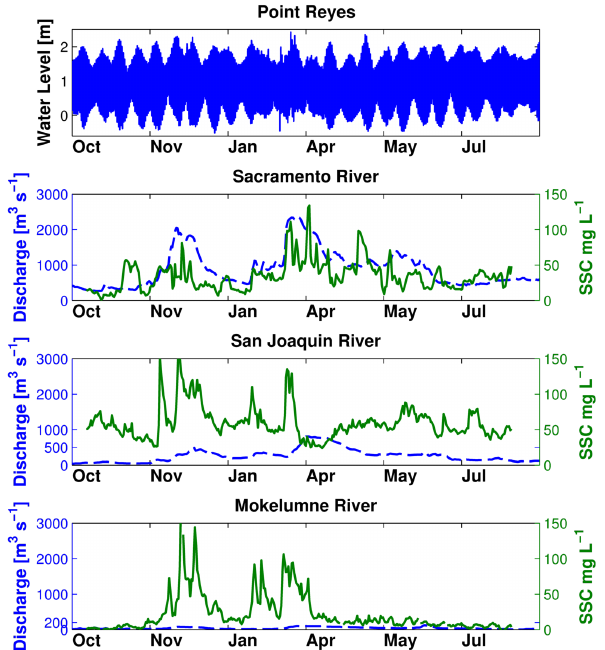
Figure 3. Input boundary conditions. The top panel is water level at Point Reyes. The lower three panels show discharge in a dashed blue line and SSC in a solid green line for Sacramento River at FPT, San Joaquin River at VNS and Mokelumne River at Woodbridge,